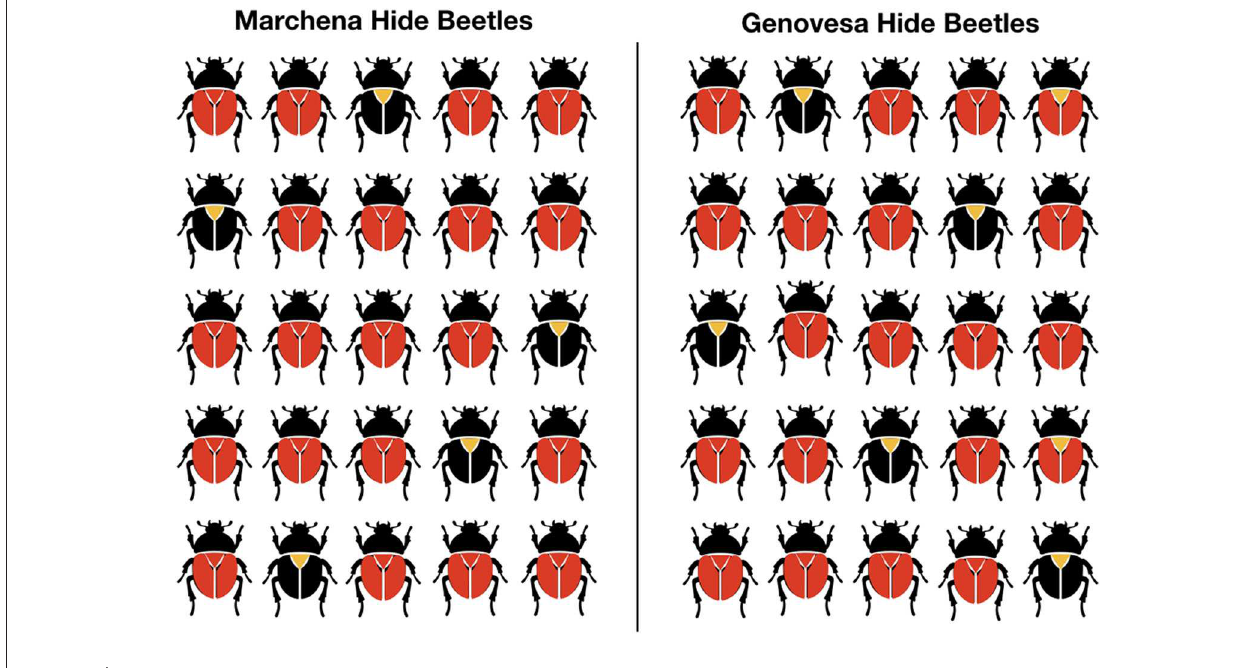
FIGURE 1 | Sample picture in the non-contrastive condition with beetles.